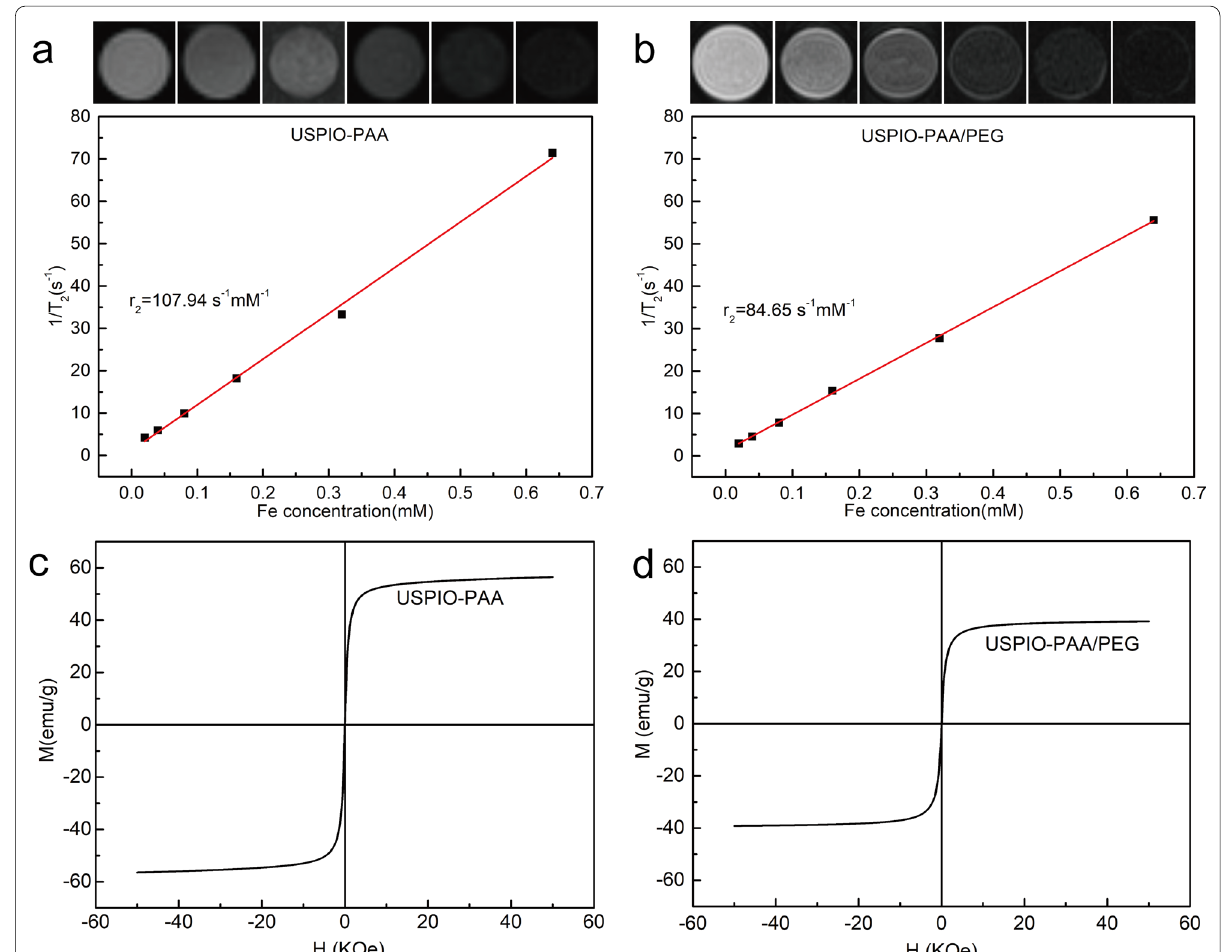
Fig. 3 In vitro magnetic response of the synthesized USPIO-PAA and USPIO-PAA/PEG NPs. a , b MRI and transverse relaxation rate of USPIO-PAA NPs ( a ) and USPIO-PAA/PEG NPs ( b ). r 2 represents relaxation rate. The relaxation rates of the USPIO-PAA and USPIO-PAA/PEG NPs were 107.94 s − 1 mM − 1 and 84.65 s − 1 mM − 1 . c , d magnetic hysteresis loops of USPIO-PAA NPs ( c ) and USPIO-PAA/PEG NPs ( d ). The magnetic hysteresis was measured at 295 k (21.85 °C) with the maximal magnetic field intensity 50,000 Oe (5 Telsa). The saturation magnetization values were close to 57 emu/g for SPIO-PAA and 40 emu/g for SPIO-PAA/PEG. Magnetization hysteresis in both curves was close to